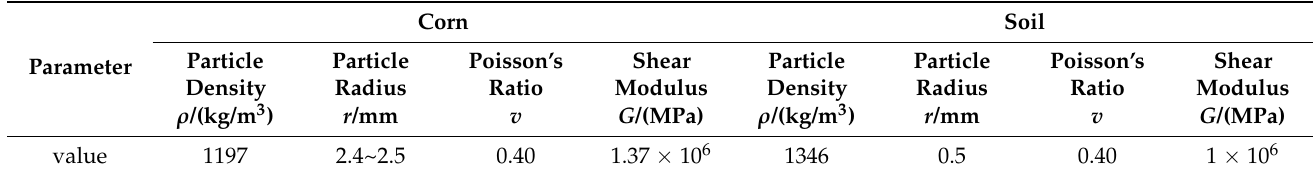
Table 2. Discrete element simulation model parameters of corn seed and